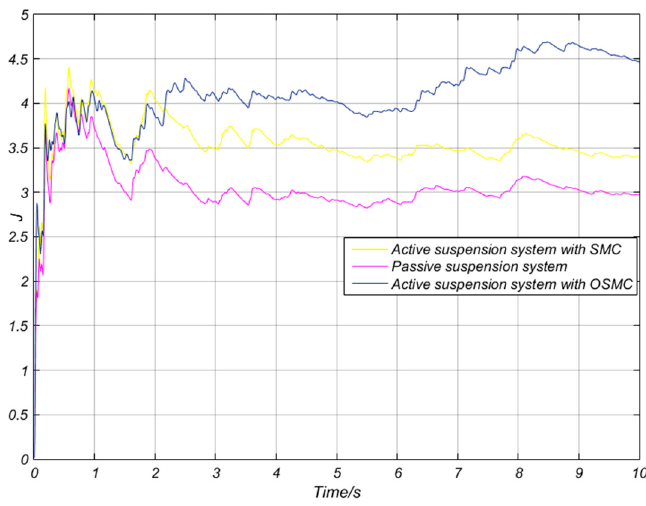
Figure 12. Performance index J of the three suspension systems.